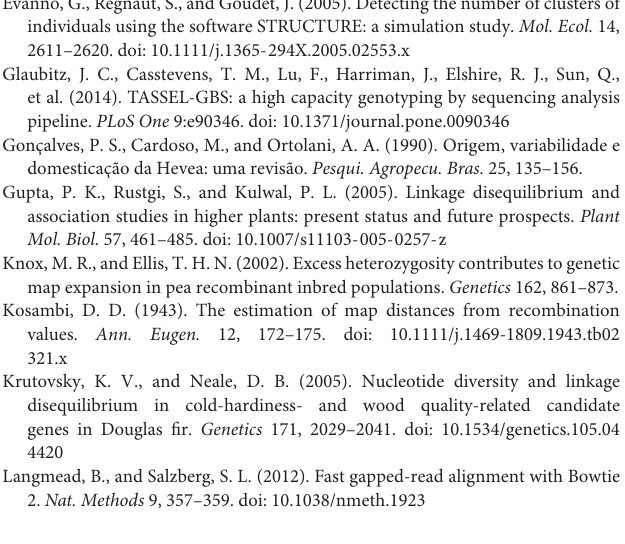
TABLE S1 | Origin of germplasm genotypes and population structure results. TABLE S2 | SNPs from GBS and their genome information. The name of markers are in agreement with the sequences of the reference genome (Tang et al., 2016). TABLE S3 | Marker information for the genetic